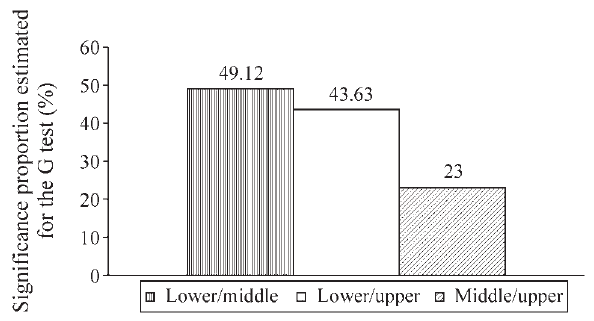
Figure5 -ProportionofRAPDpolymorphicloci(95%criterion)withsig- nificant differences (by G-test) in allele frequencies between A. altiparanae samples from each pair of sites in the lower, middle and upper Paranapanema